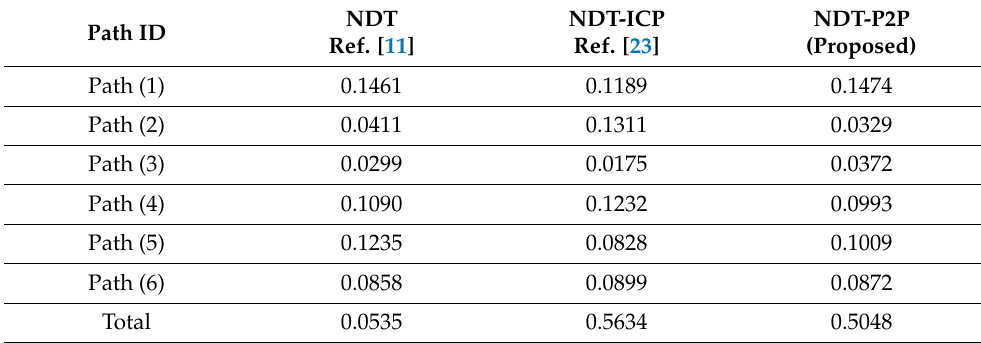
Table 4. RMSE for Figure